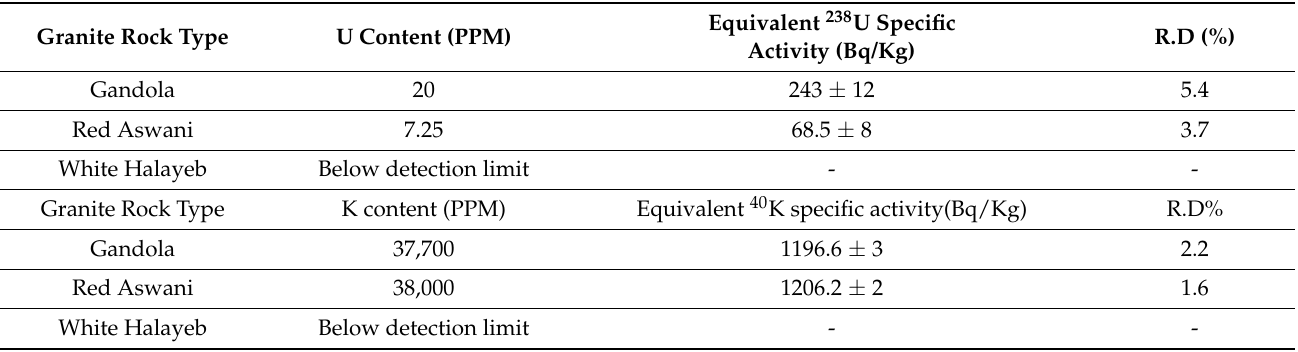
Figure 8. The specific activity by the two methods for Gandola and Red Aswani. Table 5. The elemental contents and equivalent specific activity for the three types of granites, as well as the relative deviation between the two presented methods.